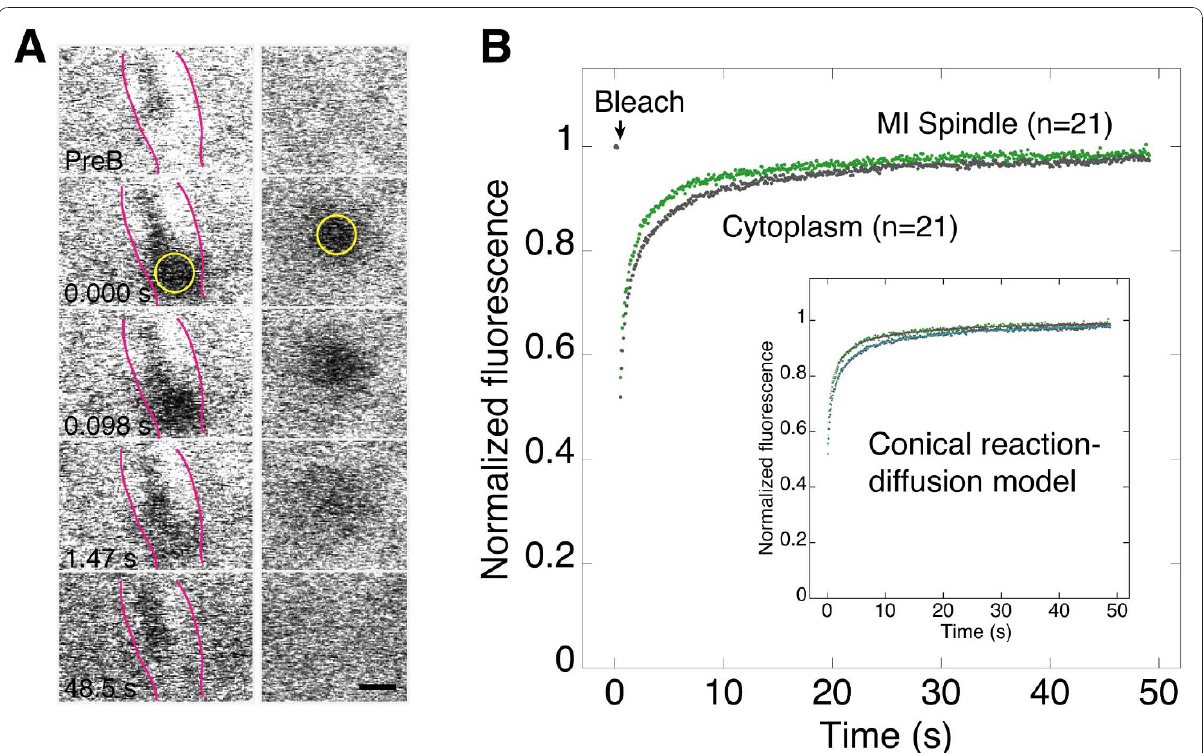
Figure 5 Fluorescence photobleaching analysis of g Tub37C in MI spindles . (A) Prebleach (PreB), bleach and recovery images from FRAP assays of g Tub37C-GFP in the oocyte MI spindle (left) and cytoplasm (right). Time, s. ROI (yellow circles; radius, w = 1.062 μ m). The MI spindle (left) is outlined to show its boundaries (pink lines). Bar, 2 μ m. (B) Mean normalized fluorescence over time (n = 21), corrected for photobleaching during the assays. For comparison, only the data for the large ROI are shown (spindle, green; cytoplasm, grey). Inset, fits to new reaction-diffusion FRAP recovery model that assumes a conical bleach profile (spindle, purple; cytoplasm, cyan).